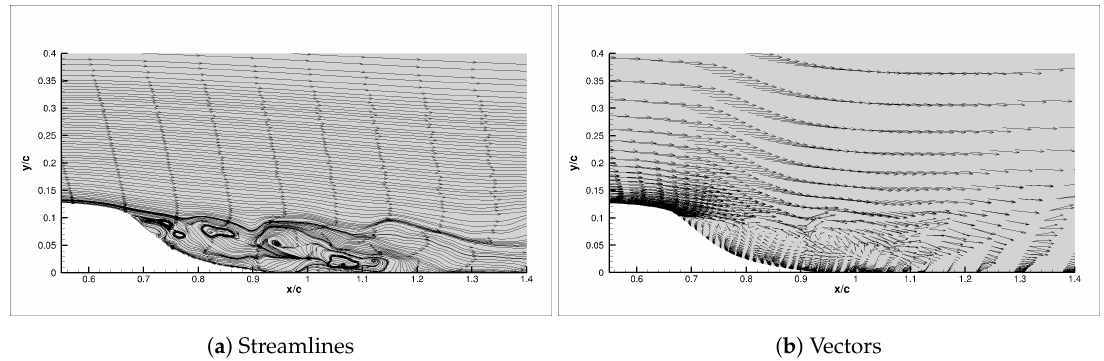
Figure 6. Velocity streamlines and vectors showing the unsteady flow